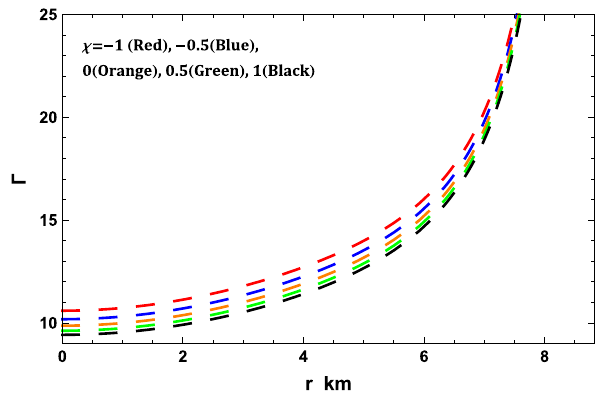
Fig. 11 Adiabatic index profiles of SMC X-4 for M = 1 . 29 M (cid:9) , R = 8 . 831 km and b = 0 . 0031km − 2